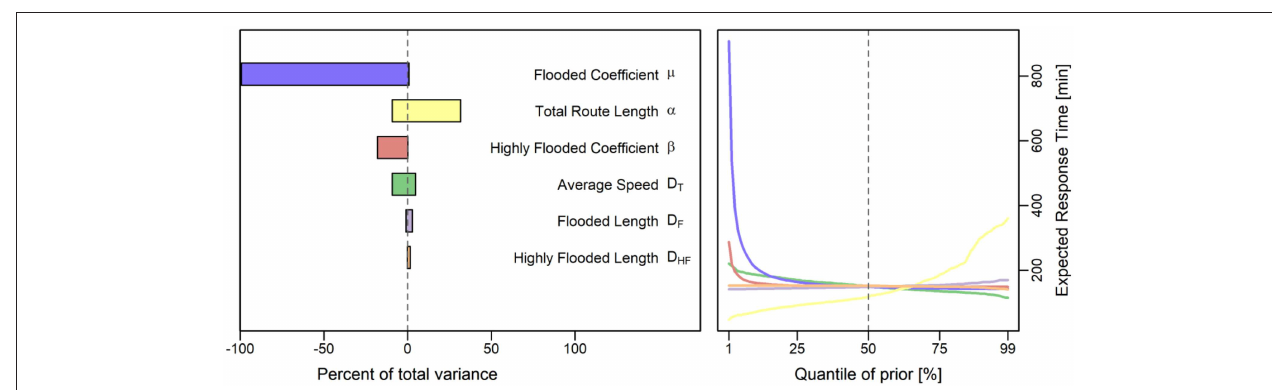
FIGURE 9 | One-at-a-time (OAT) sensitivity analysis for the emergency response time objective. Width of the bars and steepness of curve inclines indicate the degree of sensitivity to each model parameter.